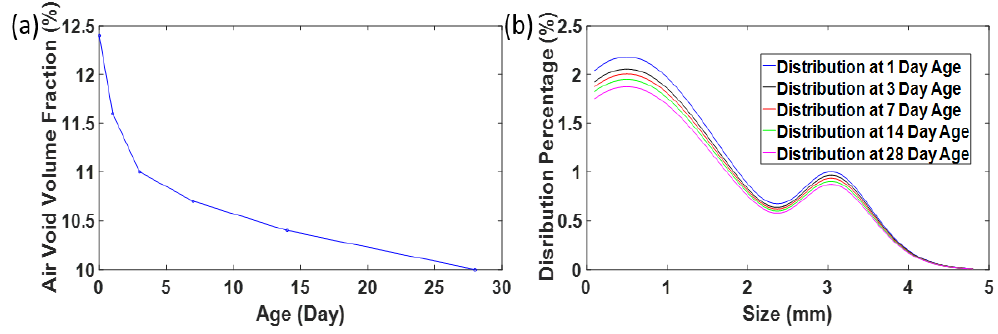
Figure 8. Air voids evolution for Sample Type 3. ( a ) Comparison of the air void content measurement with ultrasonic scattering (at early stages Day 1–28) and the ASTM C138 (Day 0); ( b ) Air void size distribution evolution with curing time.